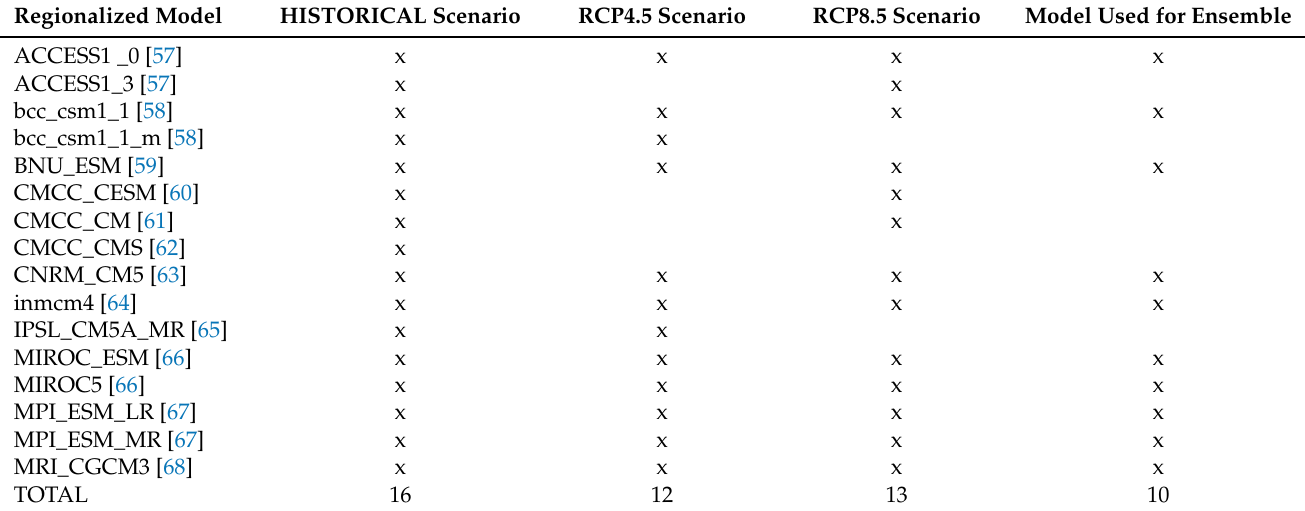
Table 1. Individual global climate models used in this study, named according to the CMIP5 (Coupled Model Intercomparison) project. Marks indicate the availability of the model in each of the studied scenarios. Last column indicate which models were used for the multi-model ensembles (MMEs) in this